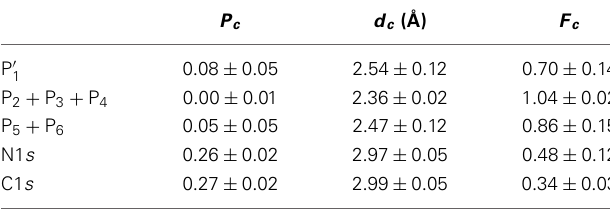
FIGURE 5 | Photoelectron spectrum, photoelectron yield and Argand diagram of C1 s core level. (A) Sum of 10 C1 s survey-PE spectra (black open circles). The two black dotted lines define the binding energy region in which the linear background (black line) is determined and the PE yield is calculated. (B) Exemplary C1 s PE yield profile (green filled circles with error bars [4]) and fitting curves (black line). Structure parameters: P c = 0 . 29 ± 0 . 01, F c = 0 . 36 ± 0 . 02, χ 2 red = 1 . 80. (C) Argand diagram of C1 s structure parameters ( P c , F c ) of each NIXSW data set (green open circles) and the corresponding average (green filled circle). Table 3 | Summary of structure parameters and adsorption